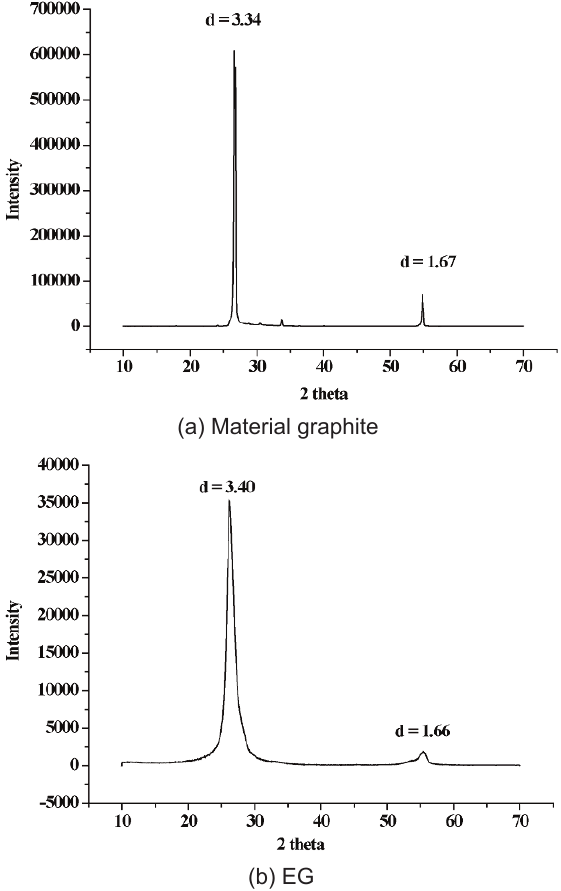
Figure 2. XRD analysis of material graphite and the EG (Cu K α radiation in the range 5° < 2 θ <